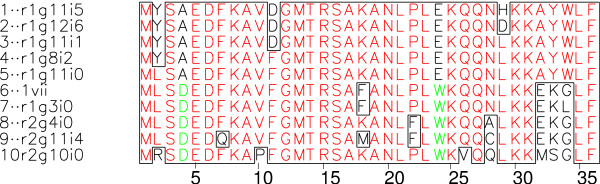
Sequence alignment of stable individuals. Multiple alignment of sequences of high-σ individuals from Fig. 5 (same numbering of sequences). The code ragbic on the left shows that sequence comes from run a ∈ {1, 2}, generation b ∈ {1, 2, ..., 15}, individual c ∈ {0, 1, ..., 7}. 1vii is the wild-type sequence. Different colors in an alignment column are used to emphasize that the column is occupied by two different residues. Boxes separate residues that are in the minority in an alignment column from the majority. Figure prepared using Prettyplot [43].